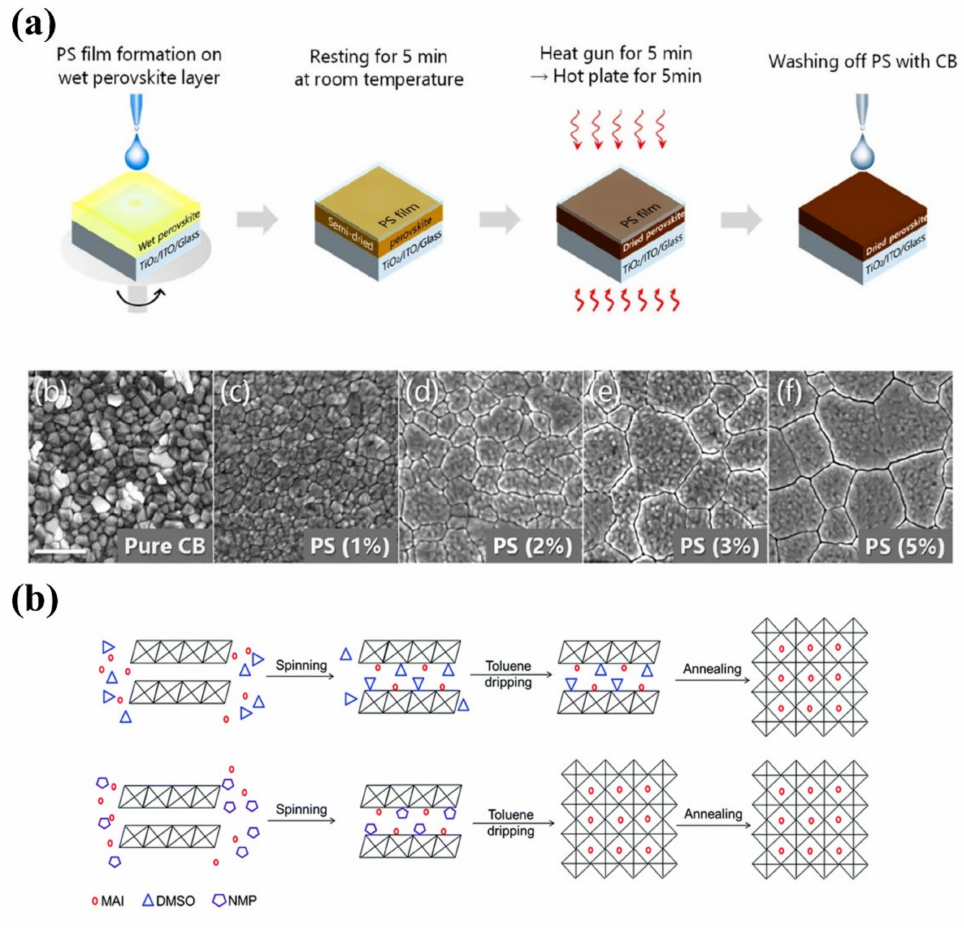
Figure 16. ( a ) Schematic of the encapsulation annealing process during perovskite layer fabrication; top-view SEM images of perovskite films fabricated using pure CB, and PS solutions: 1% PS solution, 2% PS solution, 3% PS solution, and 5% PS solution, respectively. The scale bar is 1 µ m. (Reprinted with permission from Ref. [129]. Copyright 2020 American Chemical Society). ( b ) The DMAc/DMSO and DMAc/NMP co-solvent formed perovskite schematic. Reprinted with permission from Ref. [170]. Copyright 2017 Royal Society of